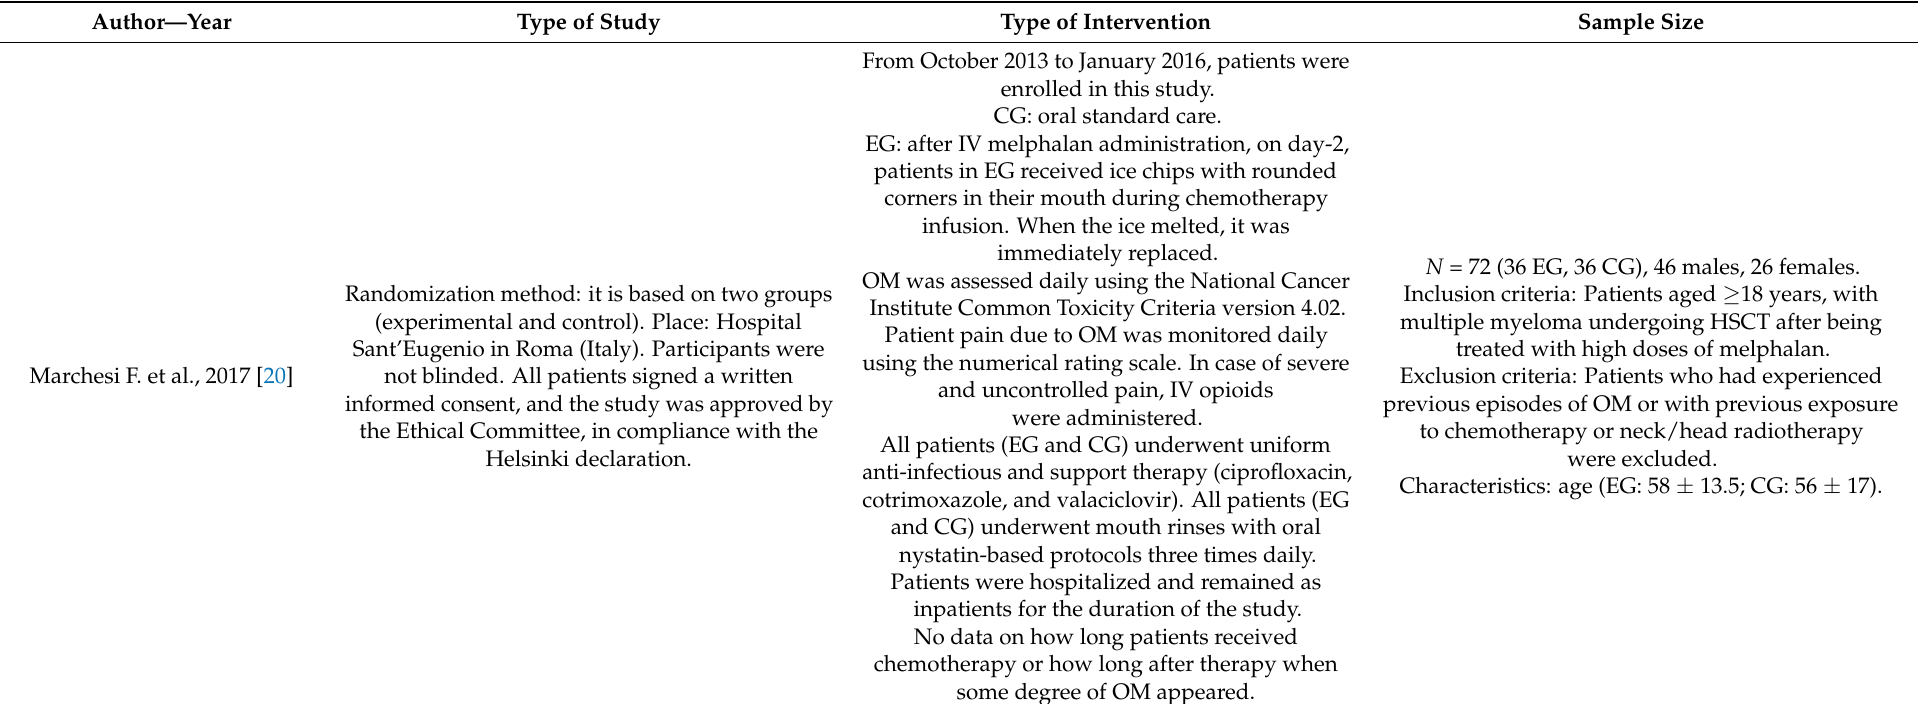
Table 2. Description of the type of study, intervention, sample size, and year of the selected